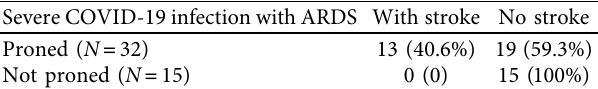
Table 5: Stroke rate between severe COVID-19 patients with ARDS who were proned vs not